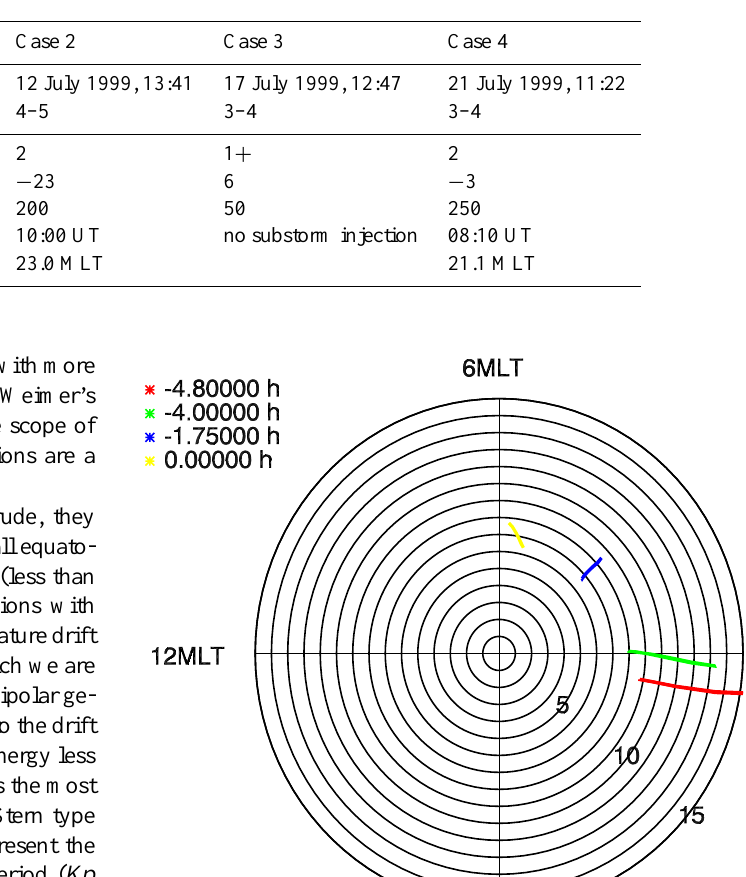
Table 2. Overview of the geomagnetic conditions for four of the observed ion clouds: the time of observation by Astrid-2, the MLT of the observed cloud, the Kp , D st and AE indexes at the observation, and time of the substorm injections, seen by LANL that occurred within 6 hours prior to the ion cloud observation by Astrid-2.